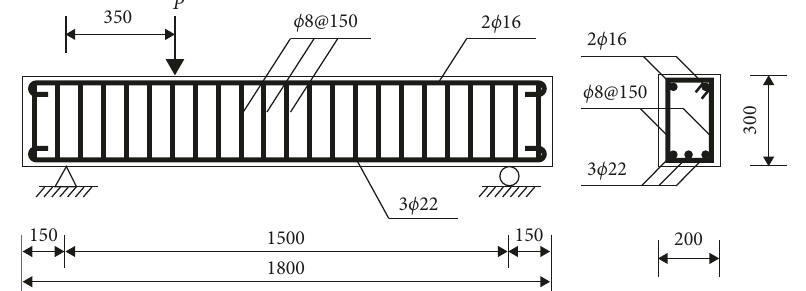
Figure 1: Profile and cross section details of the control beam [3].